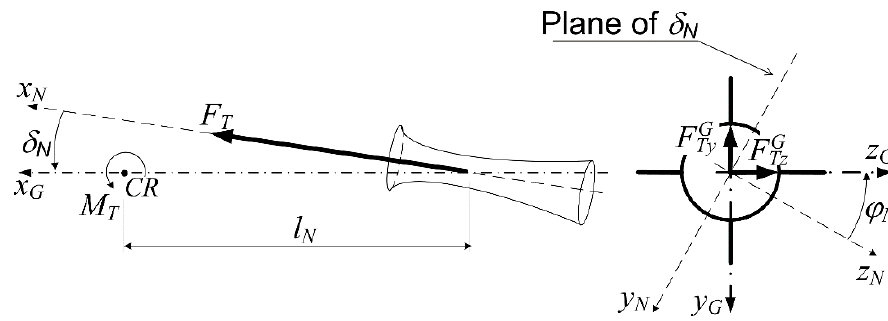
Figure 4. Deflection of the thrust force relative to the rocket axis of symmetry x G .